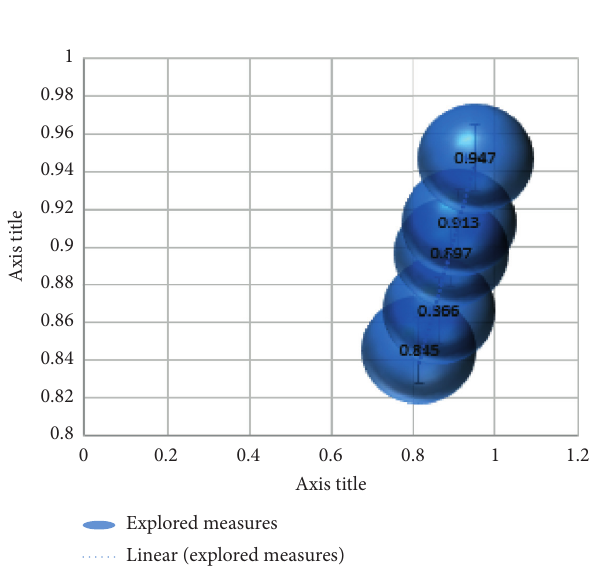
Figure 3: Graphical representation for the information of Table